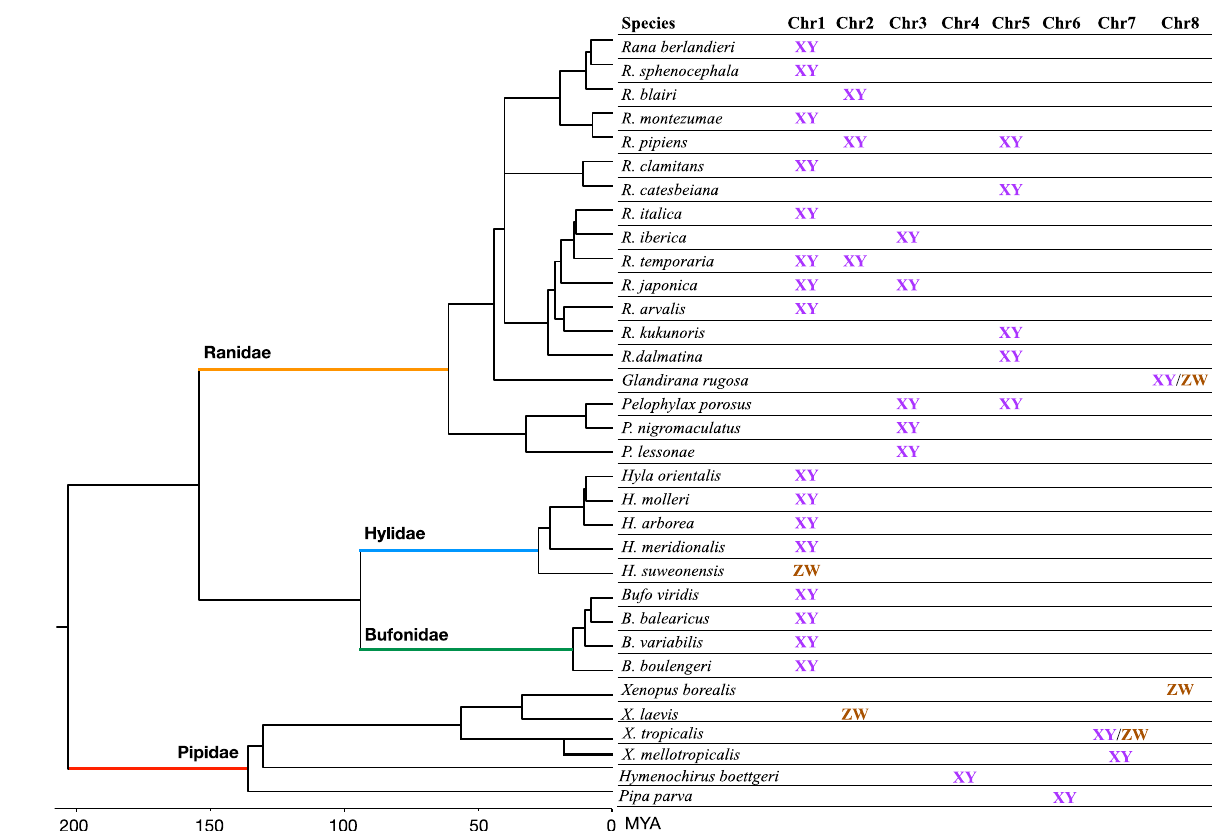
Figure 3. Overview of known sex-determination systems among anurans across four families (branch in distinct colors) spanning ~200 Mya divergence, due to the well-conserved karyotype and genome-wide synteny revealed by comparative genomics. The chromosome number is based on the genome of Xenopus tropicalis . The chromosomes (Chr9 and Chr10) that are never used as sex chromosomes are omitted. Sex chromosomes were identified from various publications [43,55,59,60,62–67]. The tree is obtained from http://www.timetree.org/, accessed on 5 February 2021 and visualized in Figtree (http://tree.bio.ed.ac.uk/software/figtree/, accessed on 5 February 2021).